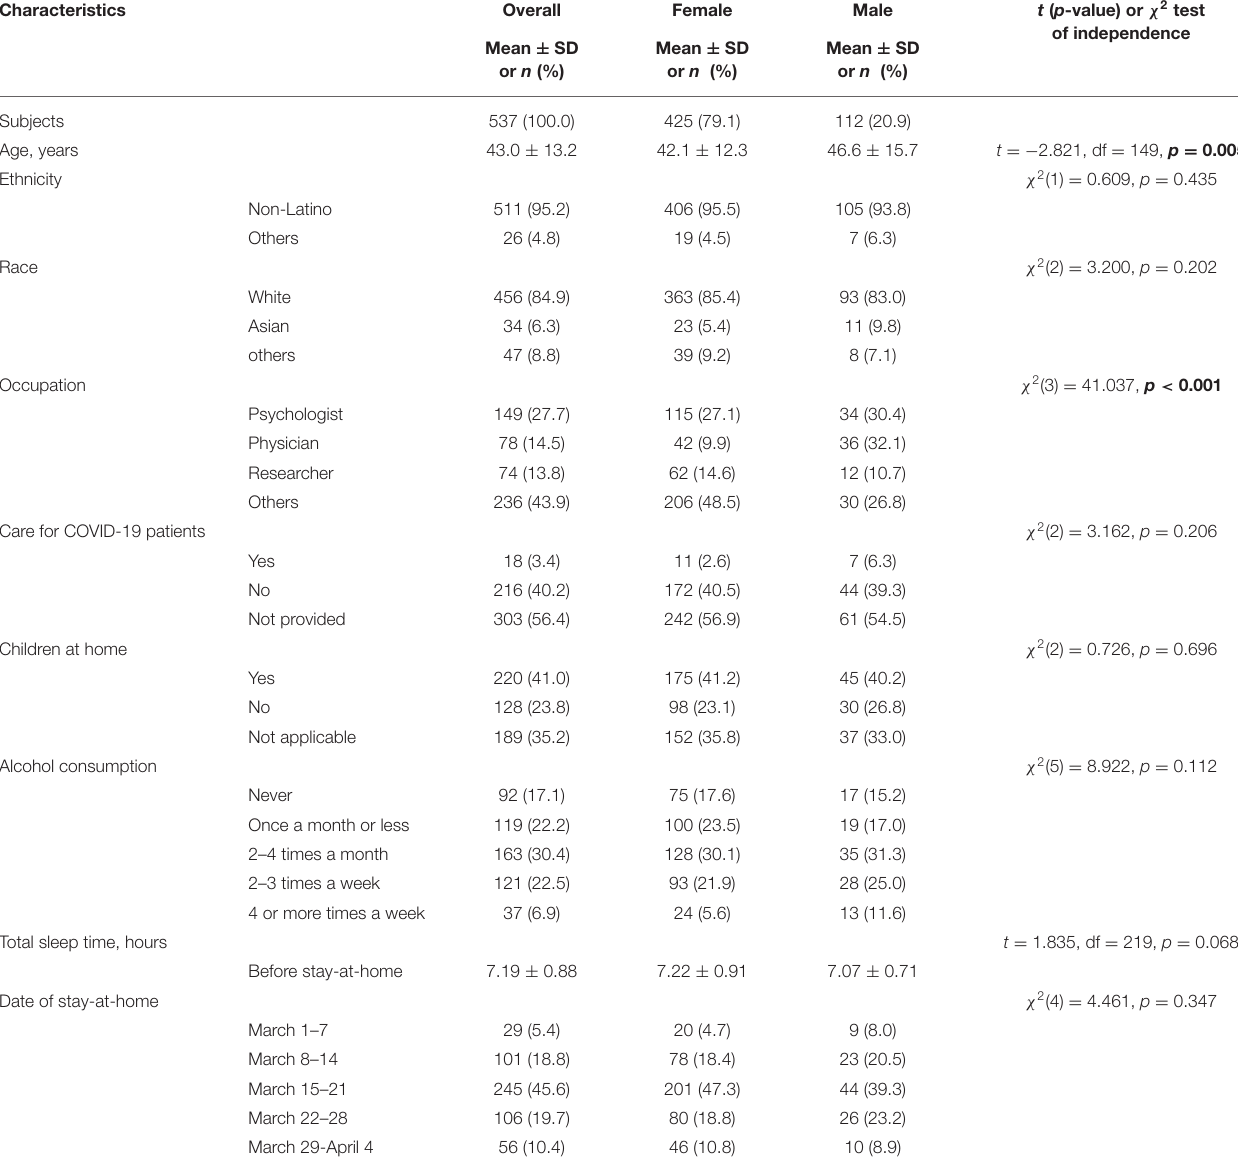
TABLE 1 | Baseline characteristics of the included healthcare workers during the COVID-19 stay-at-home orders by sex.